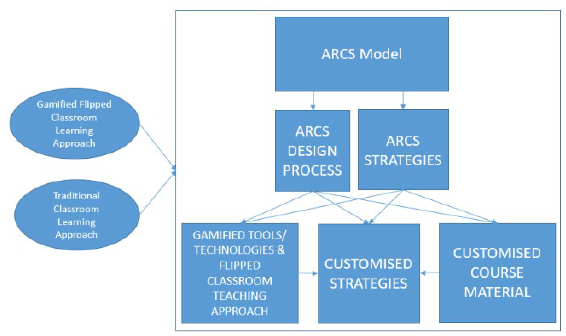
Figure 1. Conceptual framework of this